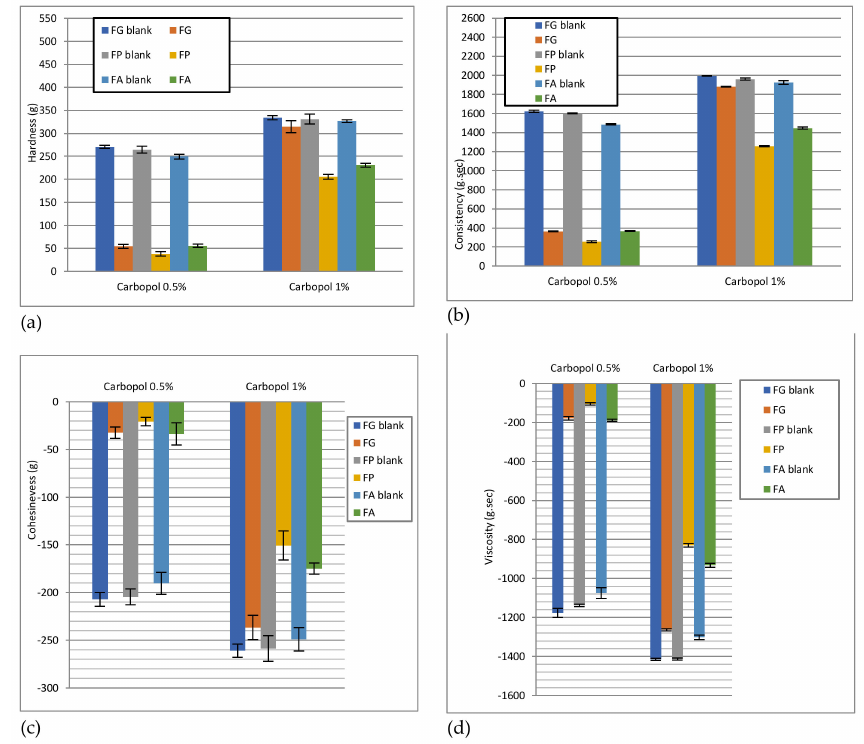
Figure 14. Textural parameters of Carbopol 940 based hydrogels determined in the back compression- extrusion test: hardness ( a ), consistency ( b ), cohesiveness ( c ), and viscosity index ( d ). Values are expressed as mean ± standard deviation ( n =